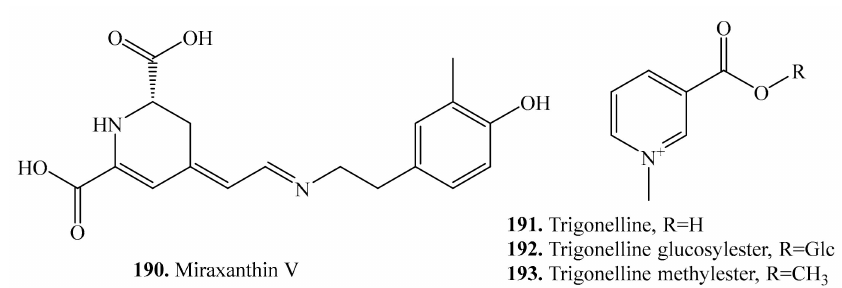
Figure 25. Structures of the nitrogen-containing metabolites isolated from